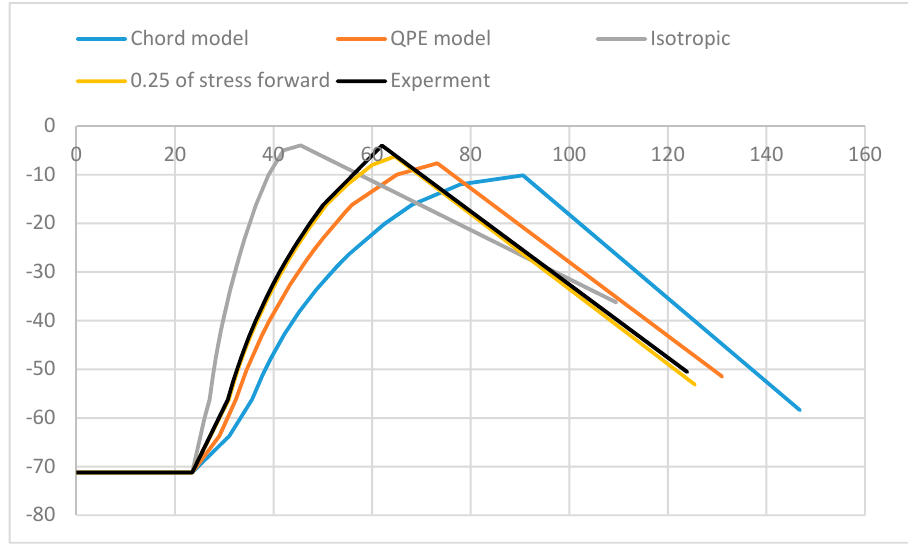
Figure 5. Springback profile of the different hardening models compared in our experiment.